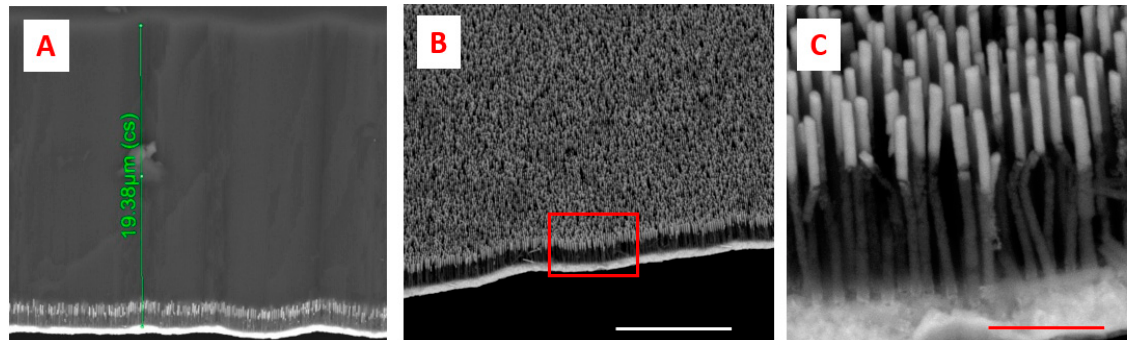
Figure 4. SEM micrographs. ( A ). Porous alumina with electroplated nanowires at the bottom near the metal contact. The thickness of the membrane is roughly 20 μ m, as indicated from the green line. ( B ). Nanowires after alumina etch( scale bar 5 μ m). ( C ). Magnified region marked as red square in Figure 3B; the scale bar is 500 nm.